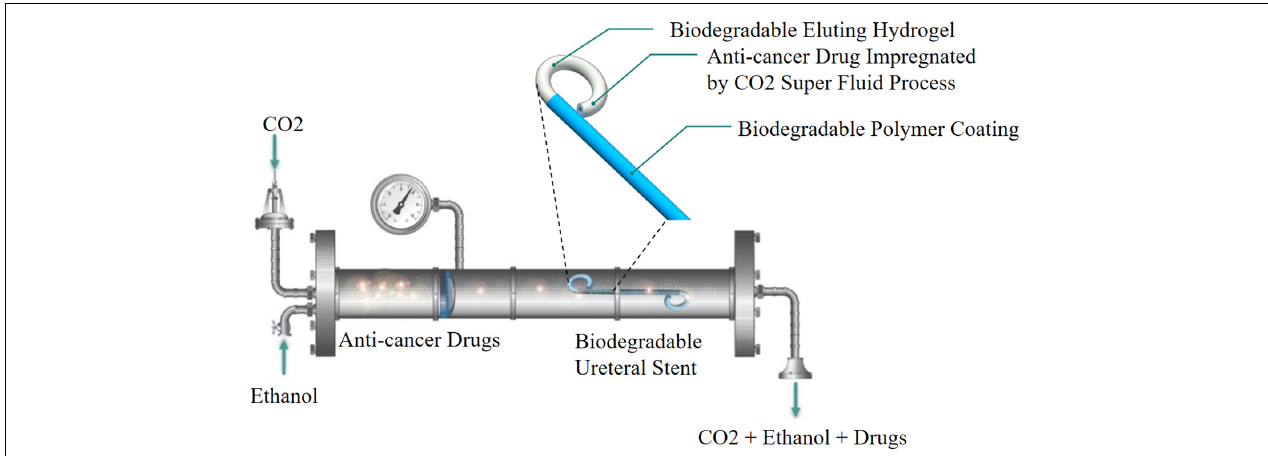
FIGURE 1 | Schematic representation of CO 2 impregnation drug-eluting BUS. Reprinted from Barros et al. (2016) under open access license.